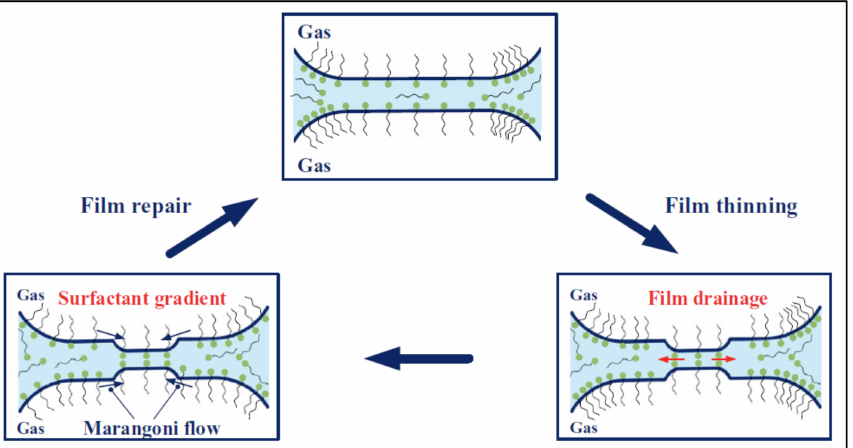
Figure 16. The self-healing process of a film by Gibbs-Marangoni effect. effect (Reprinted with the permission from Zhou et al. [24]). Copyright 2020, Published by Elsevier B.V.